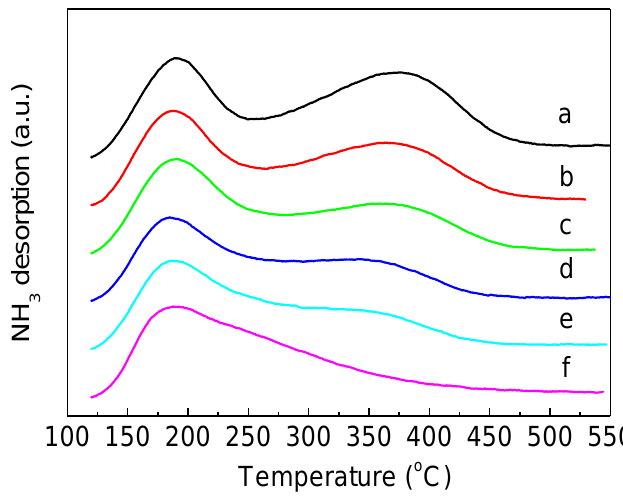
Figure 4. NH 3 -TPD profiles of parent and P-modified HZSM-5 zeolites: ( a ) HZSM-5, ( b ) 0.5% P / HZSM-5, ( c ) 1% P / HZSM-5, ( d ) 2% P / HZSM-5, ( e ) 3% P / HZSM-5 and ( f ) 5% P / HZSM-5. Table 2. Acidity characterization of HZSM-5 and P / HZSM-5 zeolites.